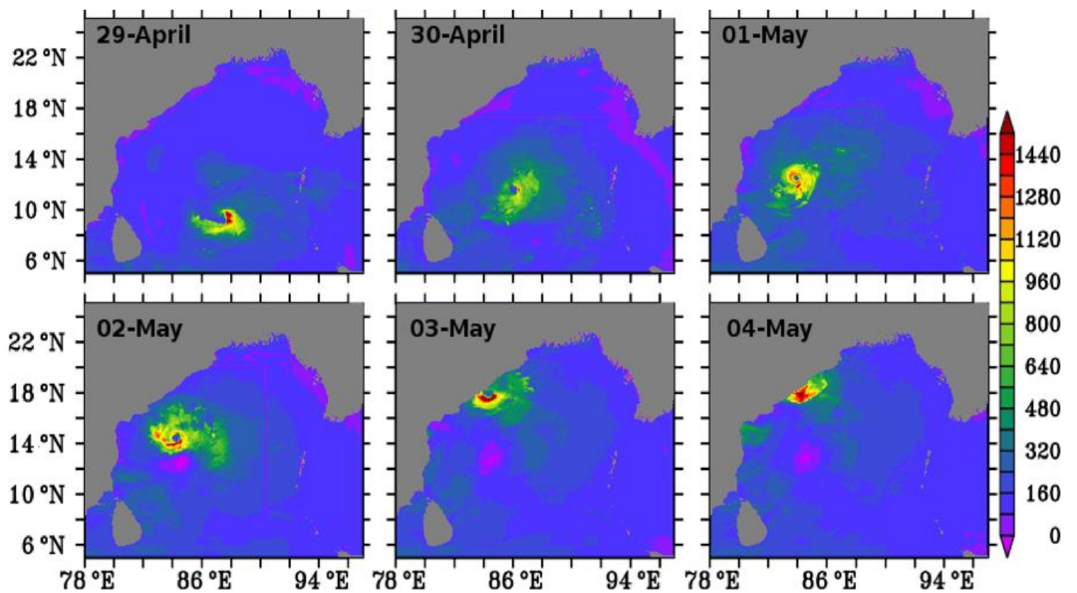
Figure 11. Model-simulated daily latent heat flux (Wm − 2 ) at 00 GMT each day for 29 April to 4 May 2019, during the passage of TC Fani over the